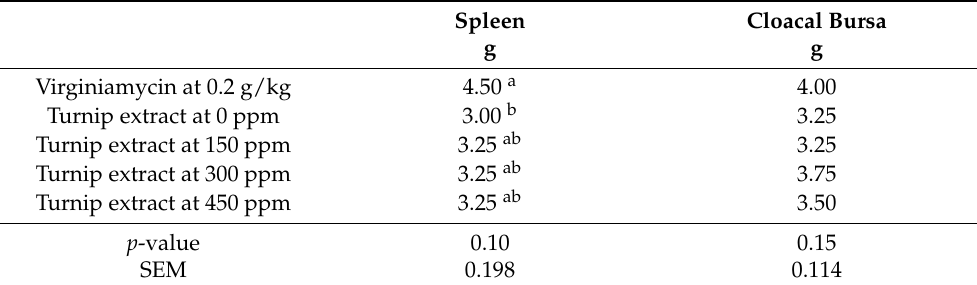
Table 6. Mean ± SEM of organ weights related to immunity of Ross broilers at day 42, for birds supplemented with different levels of Brassica rapa extract at 0–450 ppm or Virginiamycin from weeks 1–6